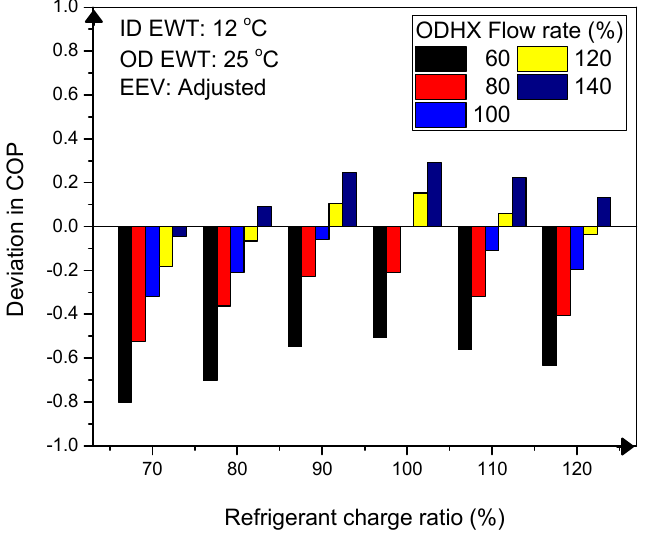
Figure 6. Change in COP with refrigerant charge and outdoor heat exchanger flow rate combined faults.